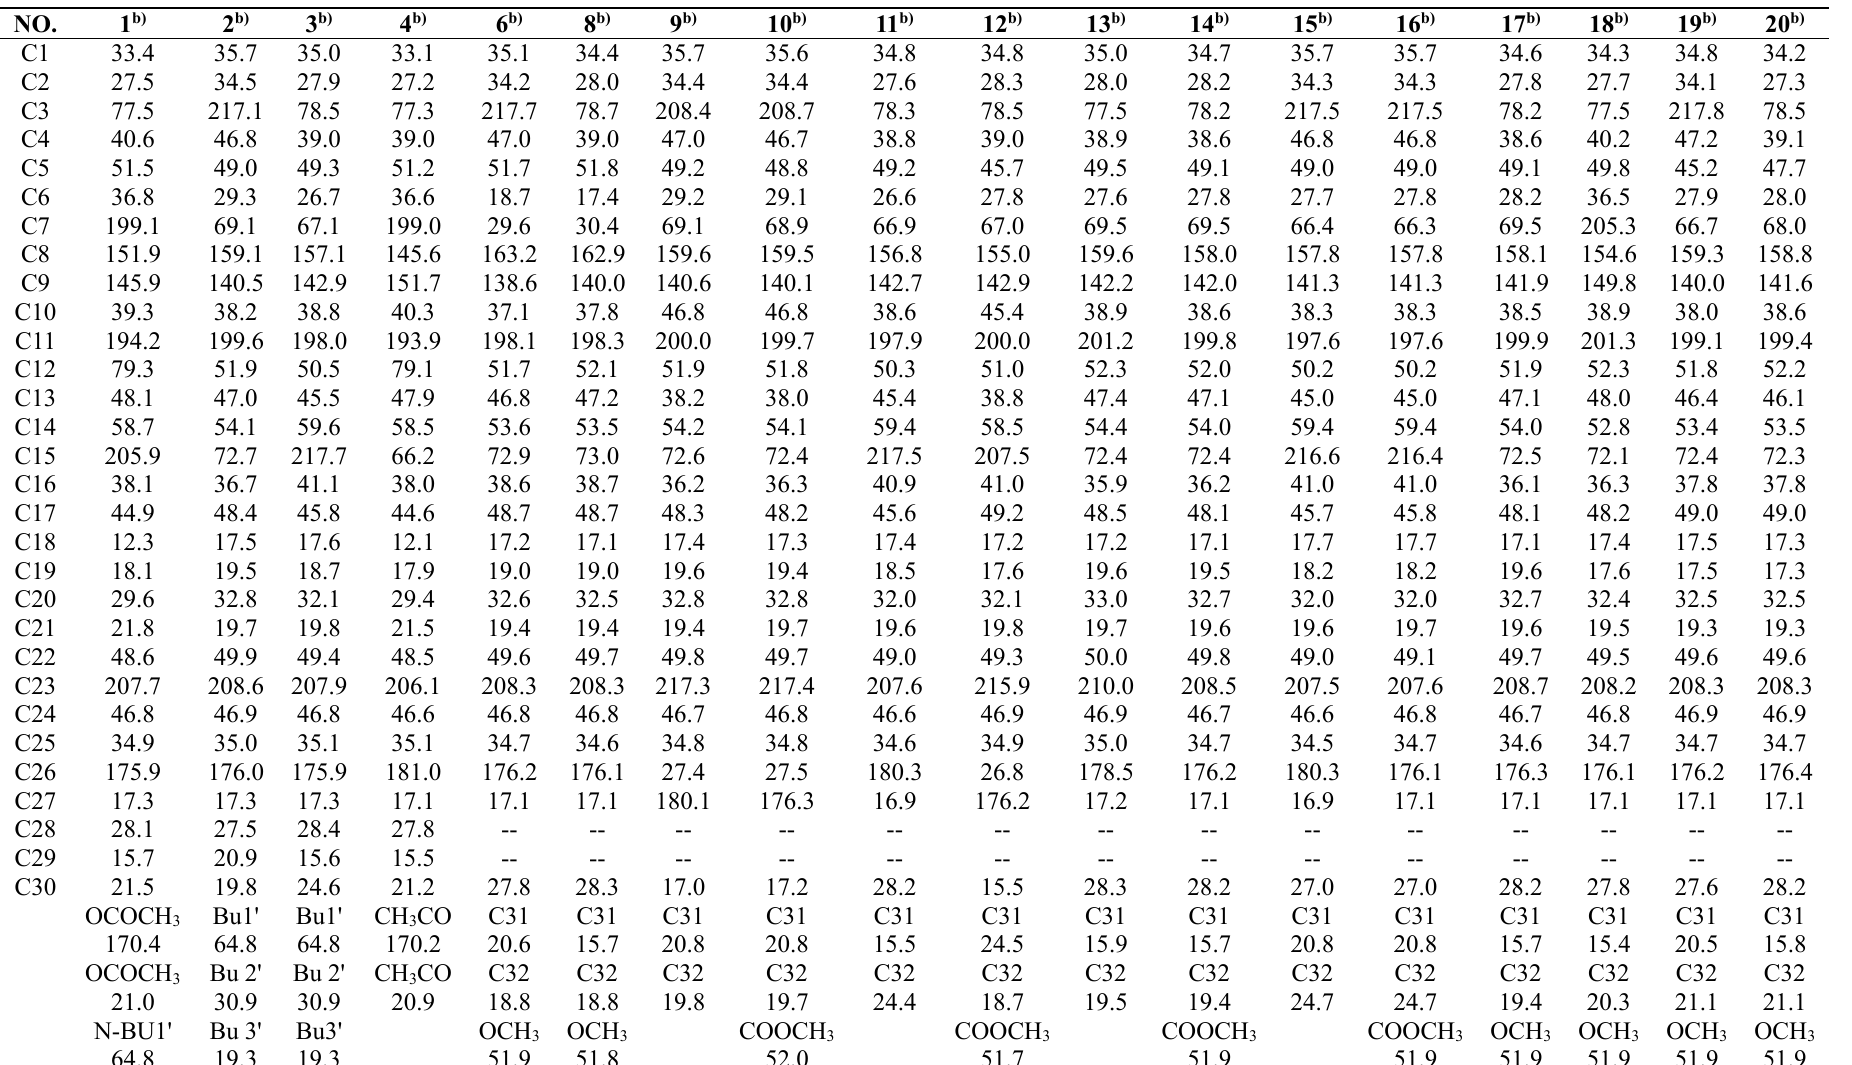
Table 12. The 13 C-NMR spectural data of compounds 1 – 316 except those which have no reported 13 C-NMR